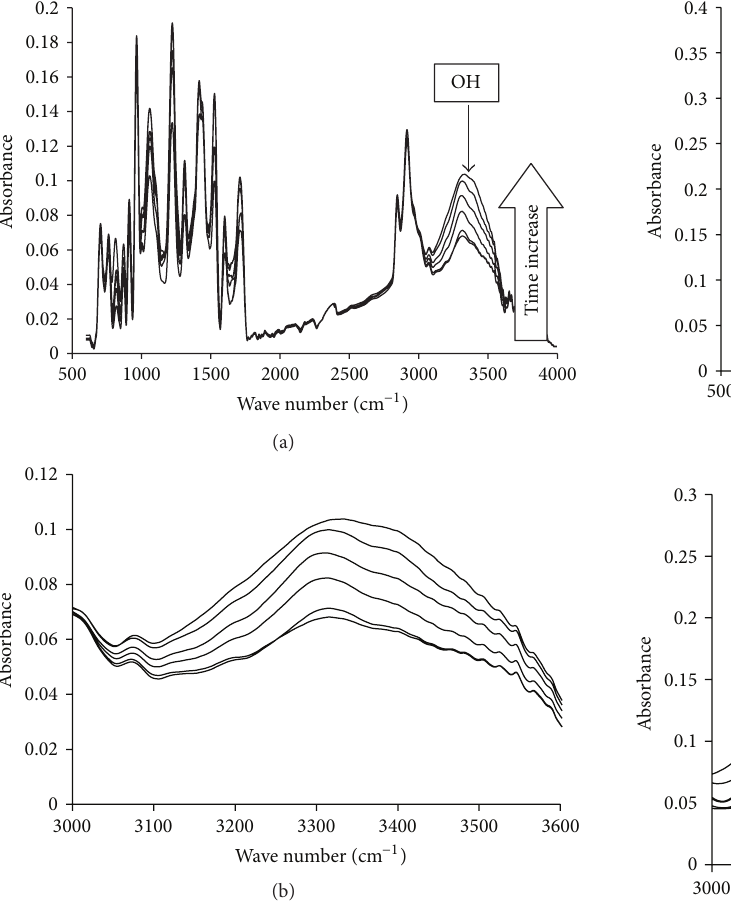
Figure 8: IR spectrogram: (a) polyurethane and (b) details of band 3400 cm −1 .